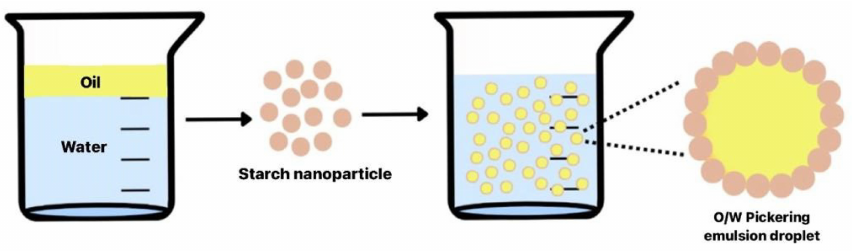
Figure 2. Application of starch nanoparticles as Pickering